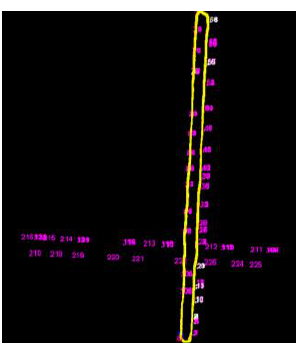
Figure 10: DG accuracy verification experiment of MMS cart